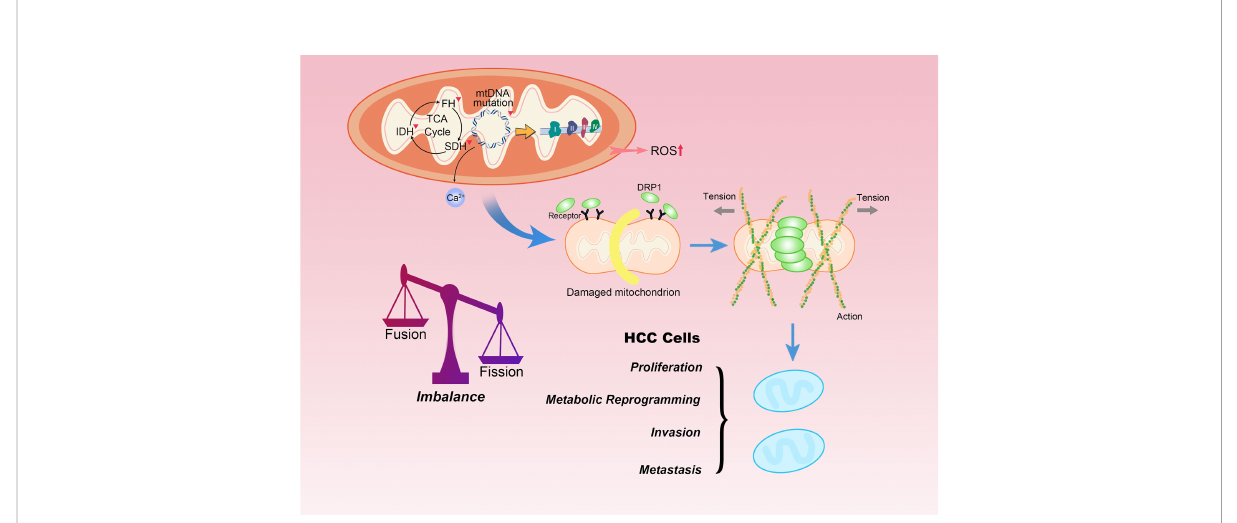
FIGURE 2 Mitochondrial dysfunction and fi ssion promote HCC progression. Mutations in mtDNA and defects in mitochondrial enzymes, such as SDH, FH and IDH are closely related to familial and sporadic cancers. The accumulation of ROS, Ca 2+ or carcinogenic metabolites can participate in tumor transformation. Moreover, mitochondrial morphology is interchangeable between fused and fi ssion states. Mitochondrial fi ssion begins with interaction with endoplasmic reticulum. DRP1 is recruited to mitochondria upon stress, where it interacts with its mitochondrial receptors. DRP1 is responsible for mitochondrial fi ssion as it physically con fi nes mitochondria by forming a ring structure in the region of future mitochondrial fi ssion. The level of mitochondrial fi ssion signi fi cantly affects the malignant biological behaviors of